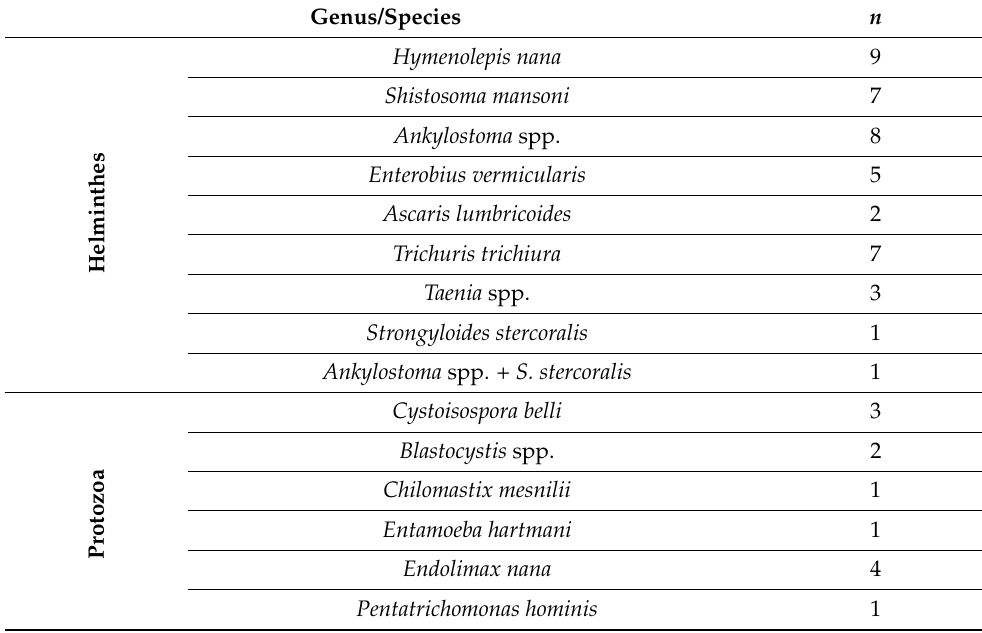
Table 2. Gastrointestinal parasites included in the study to test for possible cross-reaction (i.e., not targeted by the different PCR assays evaluated in the